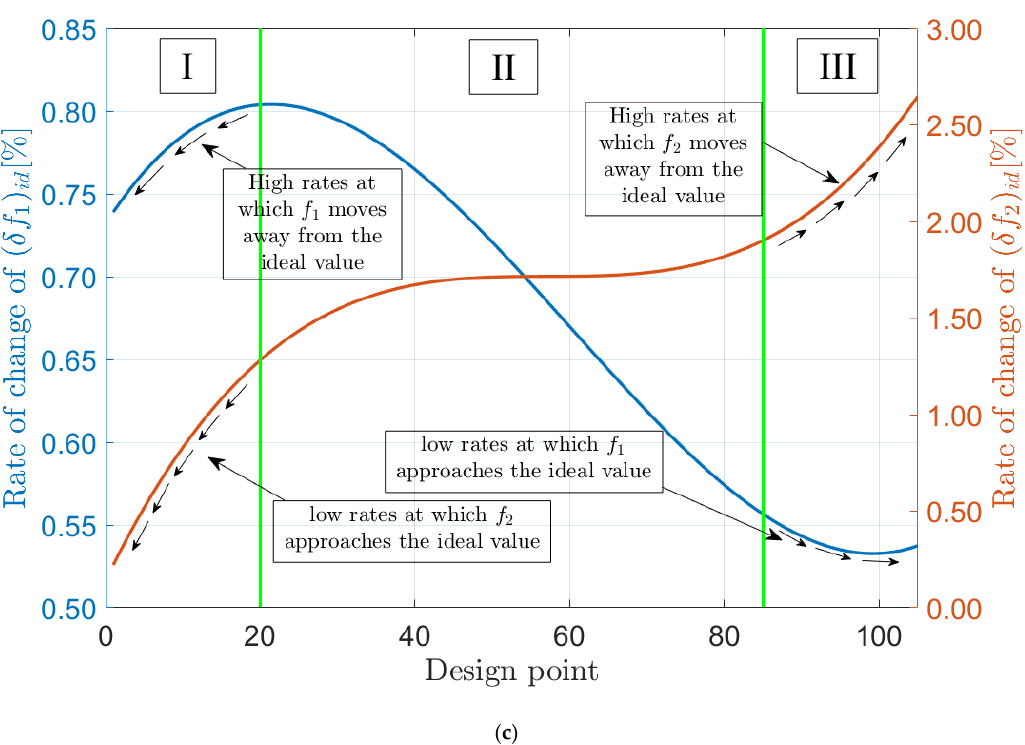
Figure 10. ( a )—Deviations from ideal solutions for both objectives, ( b )—Variability of deviations from ideal solution for different regions (I,II,III) of design points ( c )—Rates at which the criteria approach/move away from their ideal solution. Table 3. Variability of the deviations from ideal solution over considered regions of design points.